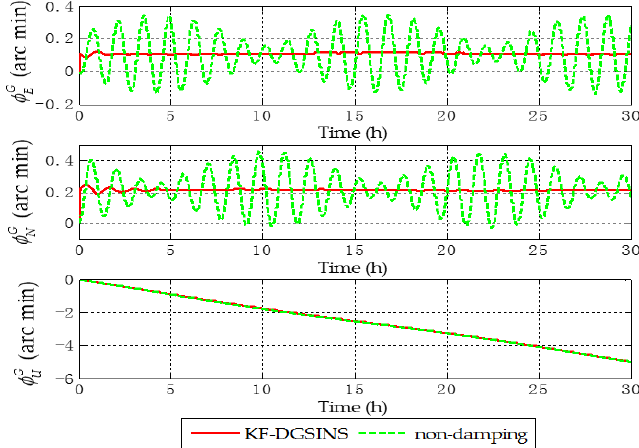
Figure 5. Grid attitude angle errors of the simulation results.